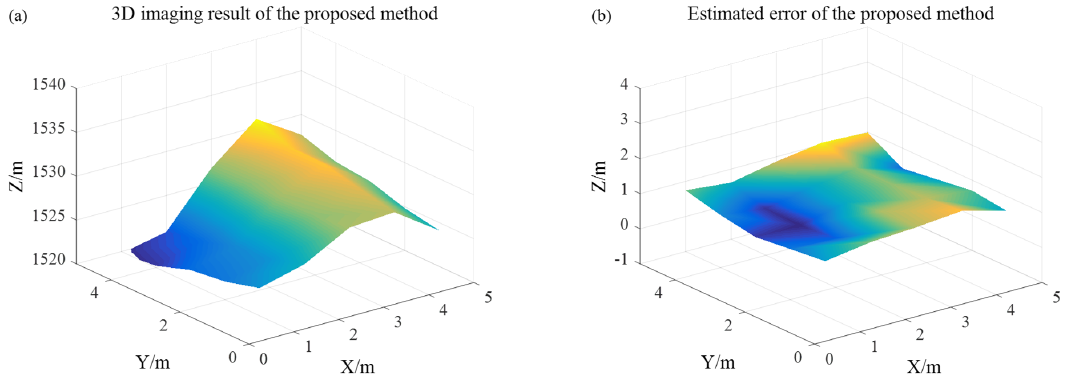
Figure 14. Ideal three dimensional (3D) imaging result ( a ) and 3D imaging result with coupling error ( b ).